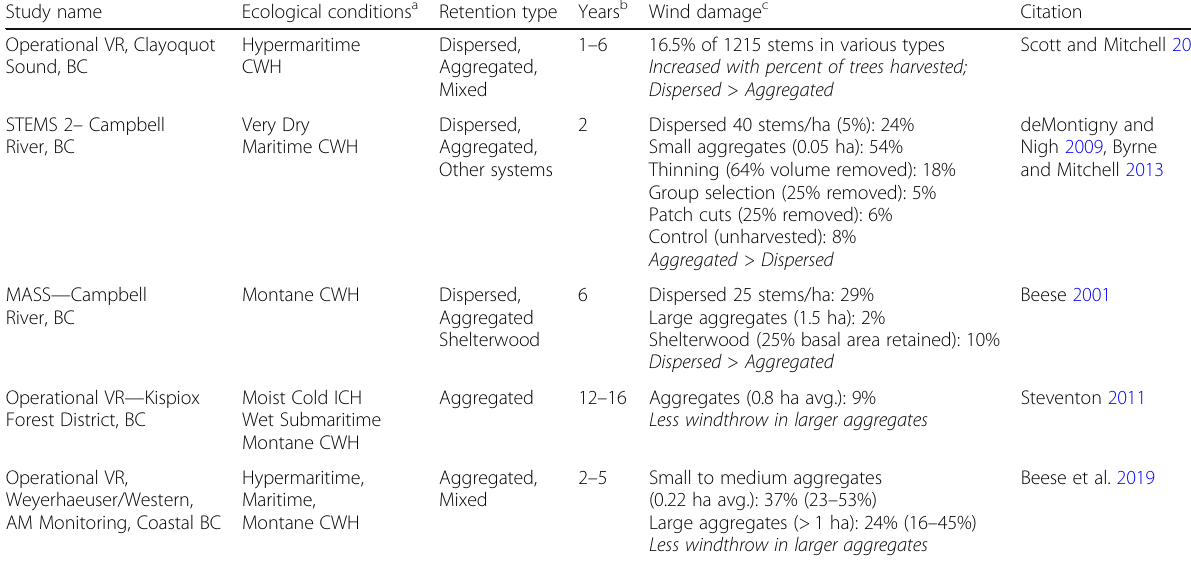
Table 1 Windthrow in variable retention trials and operational cutblocks in British